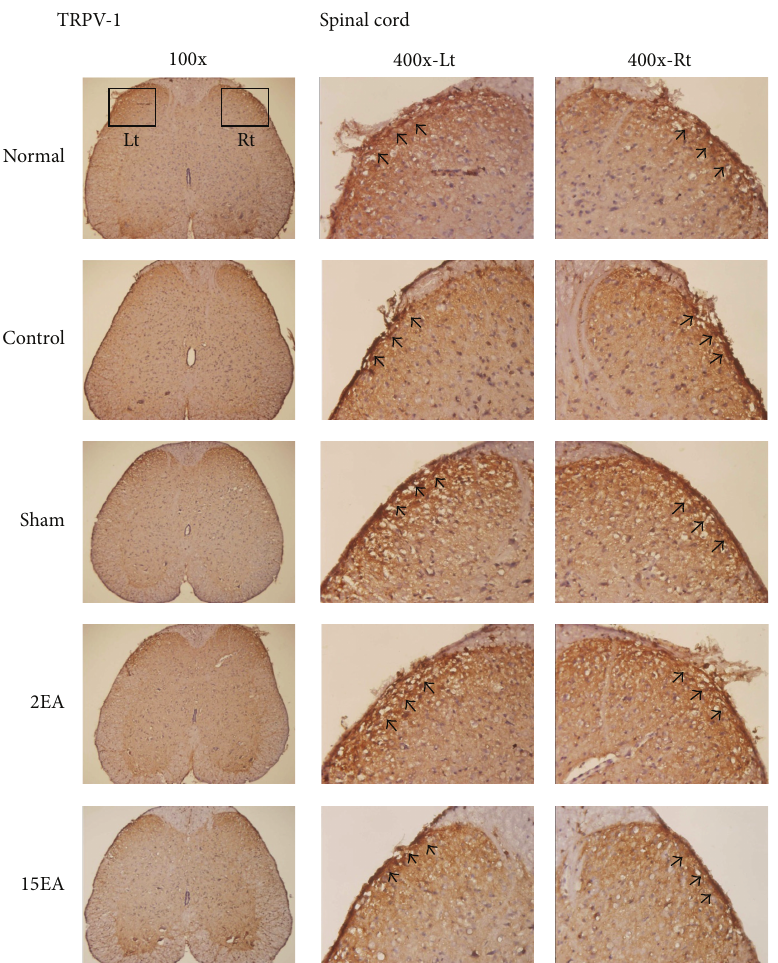
Figure5:EffectofEAonspinalTRPV1immunostainingpositivecellsinSDratswithCCI-inducedneuropathicpain.TRPV1immunostaining positivecells(arrow)inthespinalcord(Spinalcord)weresimilaramongnormalgroup(normal),controlgroup(control),shamgroup(sham), 2EA group (2EA), and 15EA group (15EA); Lt= left side of spinal cord; Rt = right side of spinal